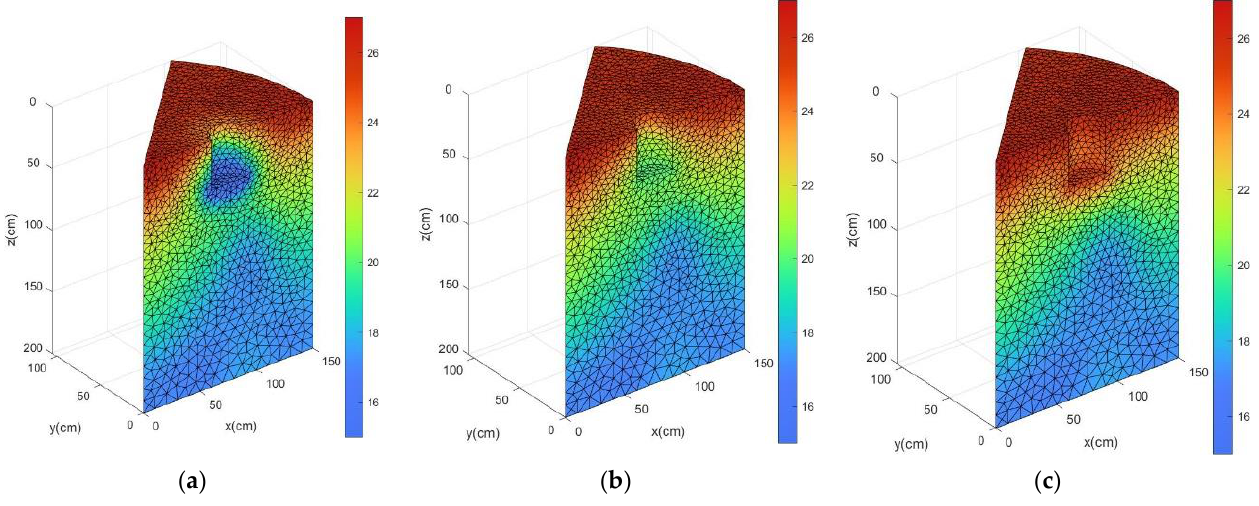
Figure 15. Simulation of soil temperature under different irrigation water temperatures. ( a ) Water temperature: 15 ◦ C; ( b ) Water temperature: 20 ◦ C; ( c ) Water temperature: 25 ◦ C. Table 12. Calculation of statistical indexes for 0 – 80 cm soil temperature under different irrigation water temperature.